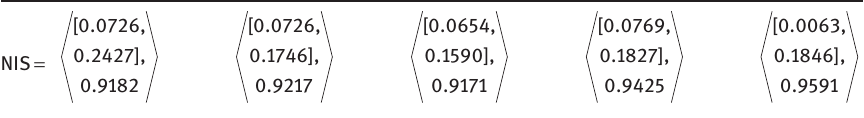
Table 13: Negative Ideal Solutions.